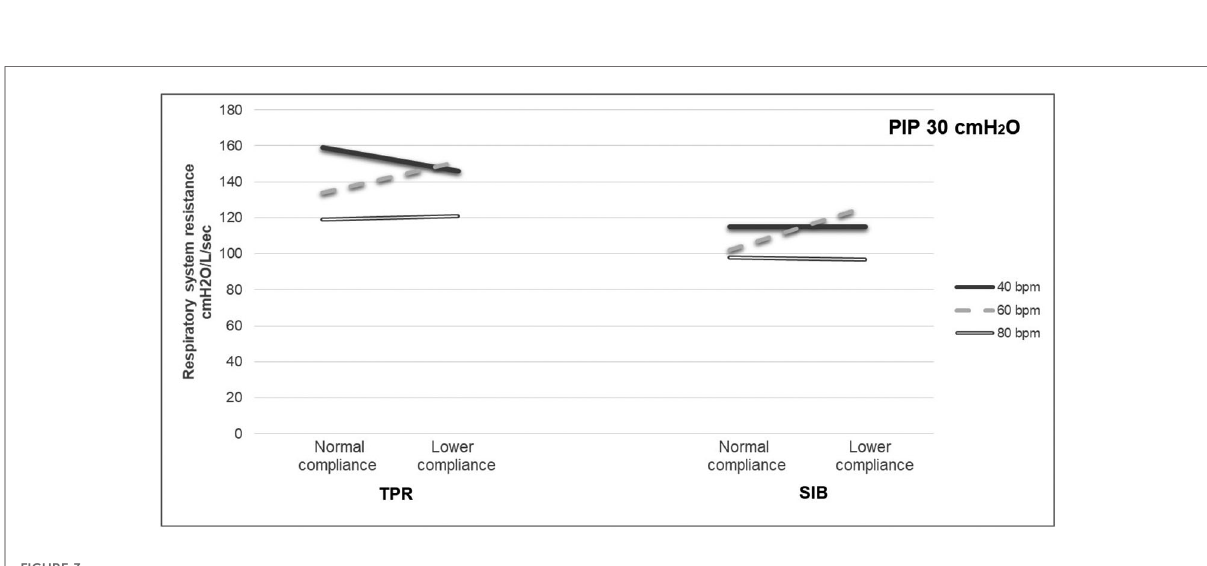
FIGURE 3 R rs using a TPR and SIB at PIP of 18 cmH